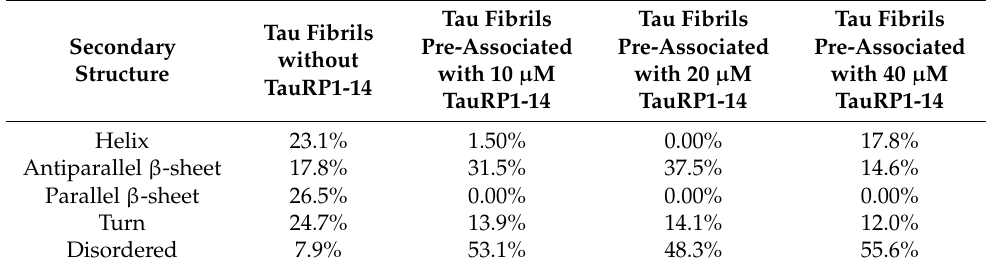
Table 6. Secondary elements detected in CD spectra upon interactions with TauRP (1–14) with fibrillar Tau.